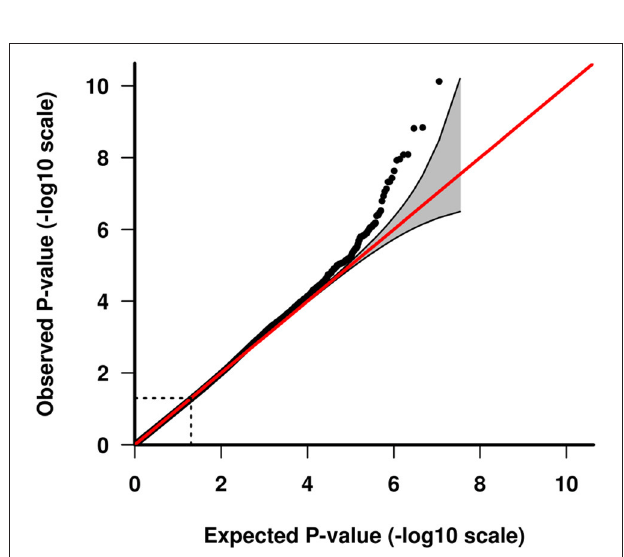
FIGURE 3 | Quantile-quantile plot of GWAS analysis. The area shaded in gray indicates the 95% confidence interval under the null.